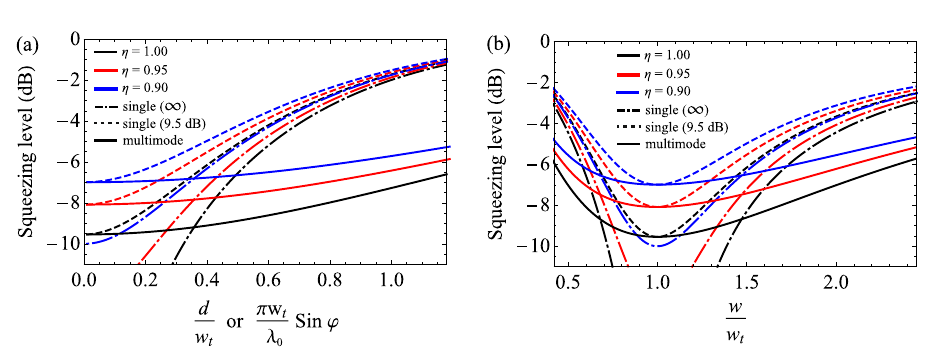
η corresponds to the total optical loss − 1 (black), η 0.95 (red), and η 0.9 = = = 1 / 81 ). =